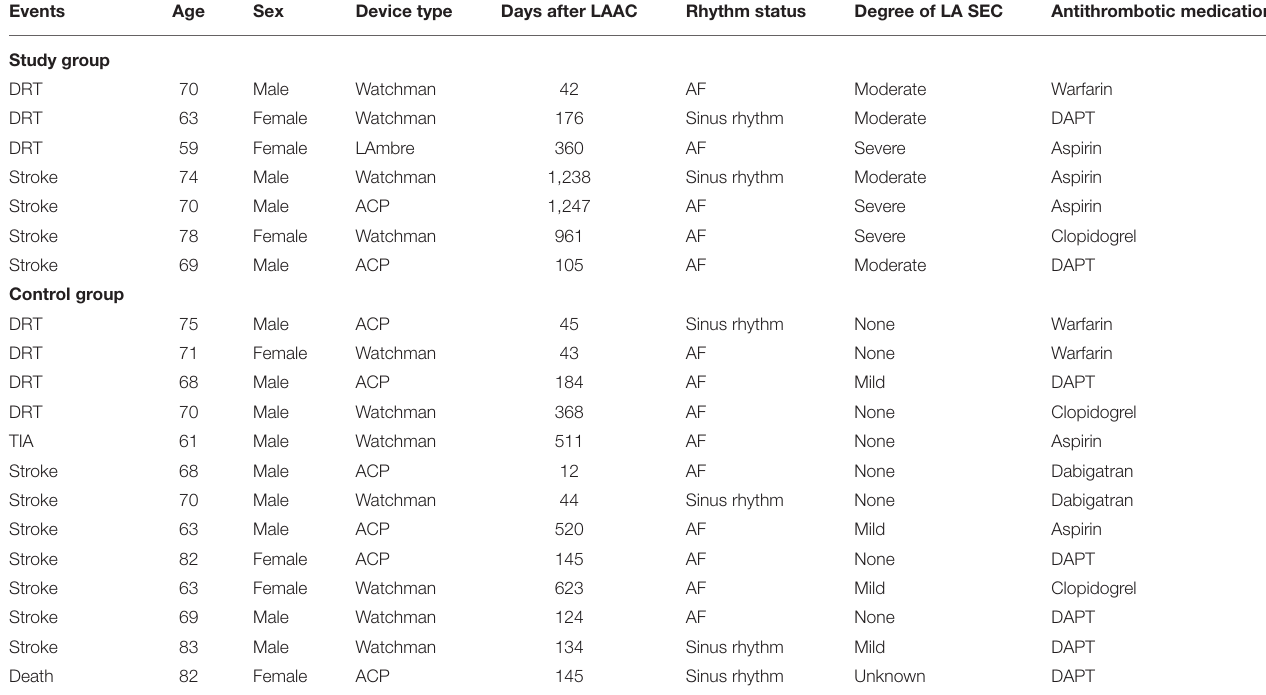
TABLE 4 | DRT and clinical outcomes. Events Sex Device type Days after LAAC Rhythm status Degree of LA SEC Antithrombotic medication Study